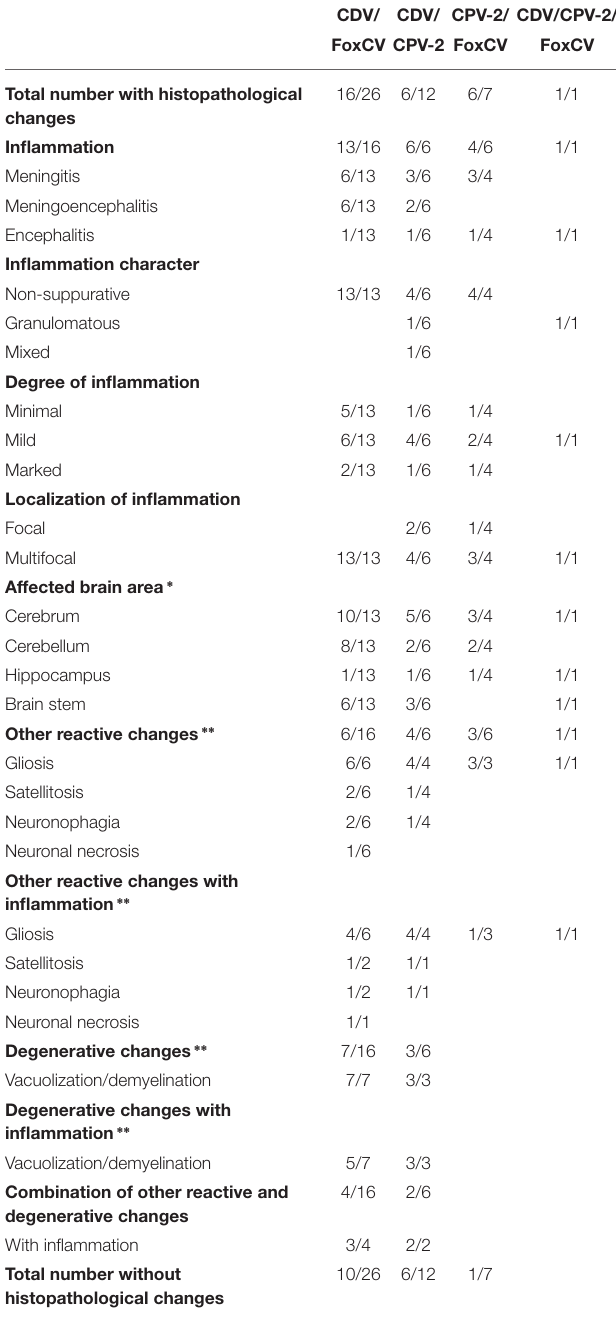
TABLE 2 | Histopathological findings in animals with the various combinations of canine distemper virus (CDV), canine parvovirus type 2 (CPV-2), and/or fox circovirus